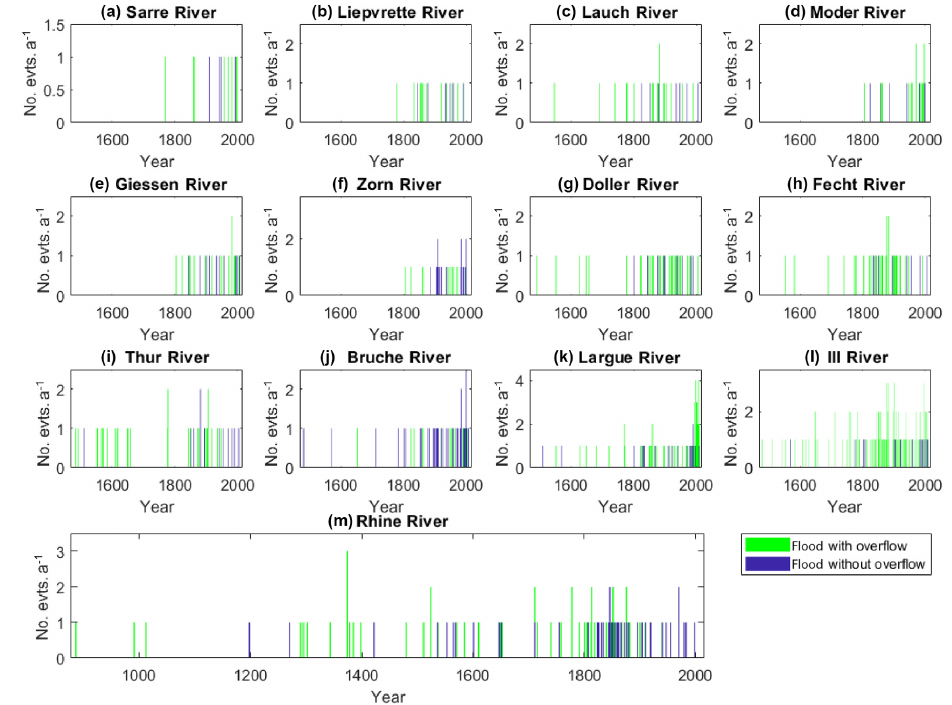
Figure 11. Individual chronologies for the 13 studied rivers: events with and without water